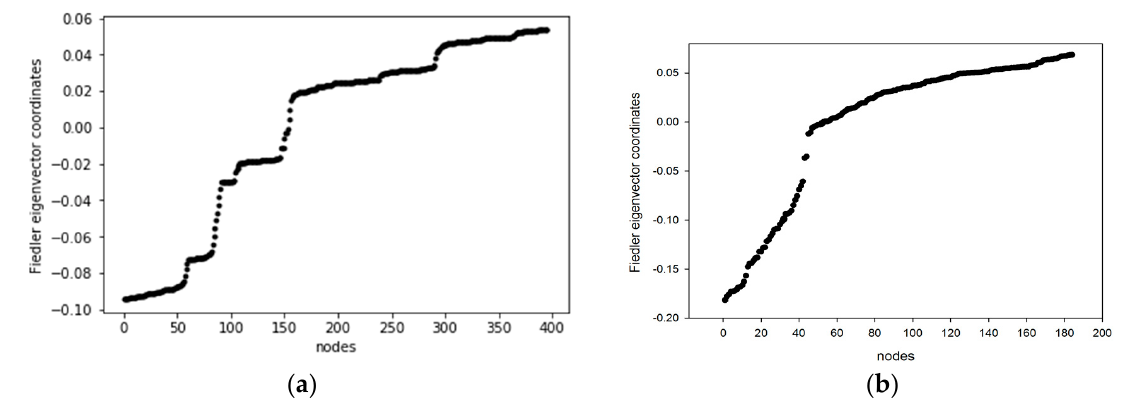
Figure 7. Fiedler eigenvector v 2 coordinates for the two case studies: ( a ) C-Town network; and, ( b ) Parete network.